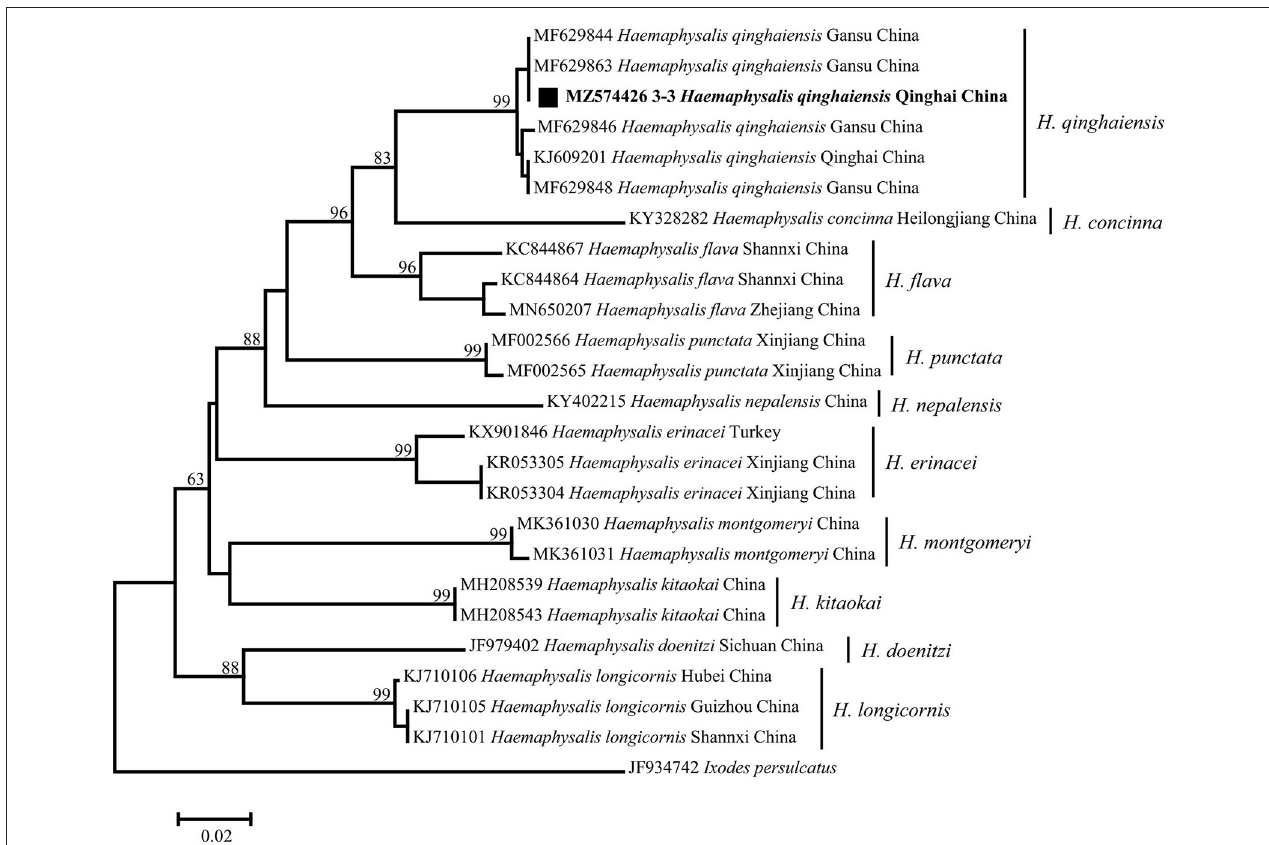
FIGURE 3 | Phylogenetic tree based on the mitochondrial 16S rRNA gene (460 bp) of Haemaphysalis spp. obtained in this study. Bootstraps analysis was performed with 500 replicates. The solid square indicates sequence from this study. One sequence from this study is bolded. Ixodes persulcatus (JF934742) was used as